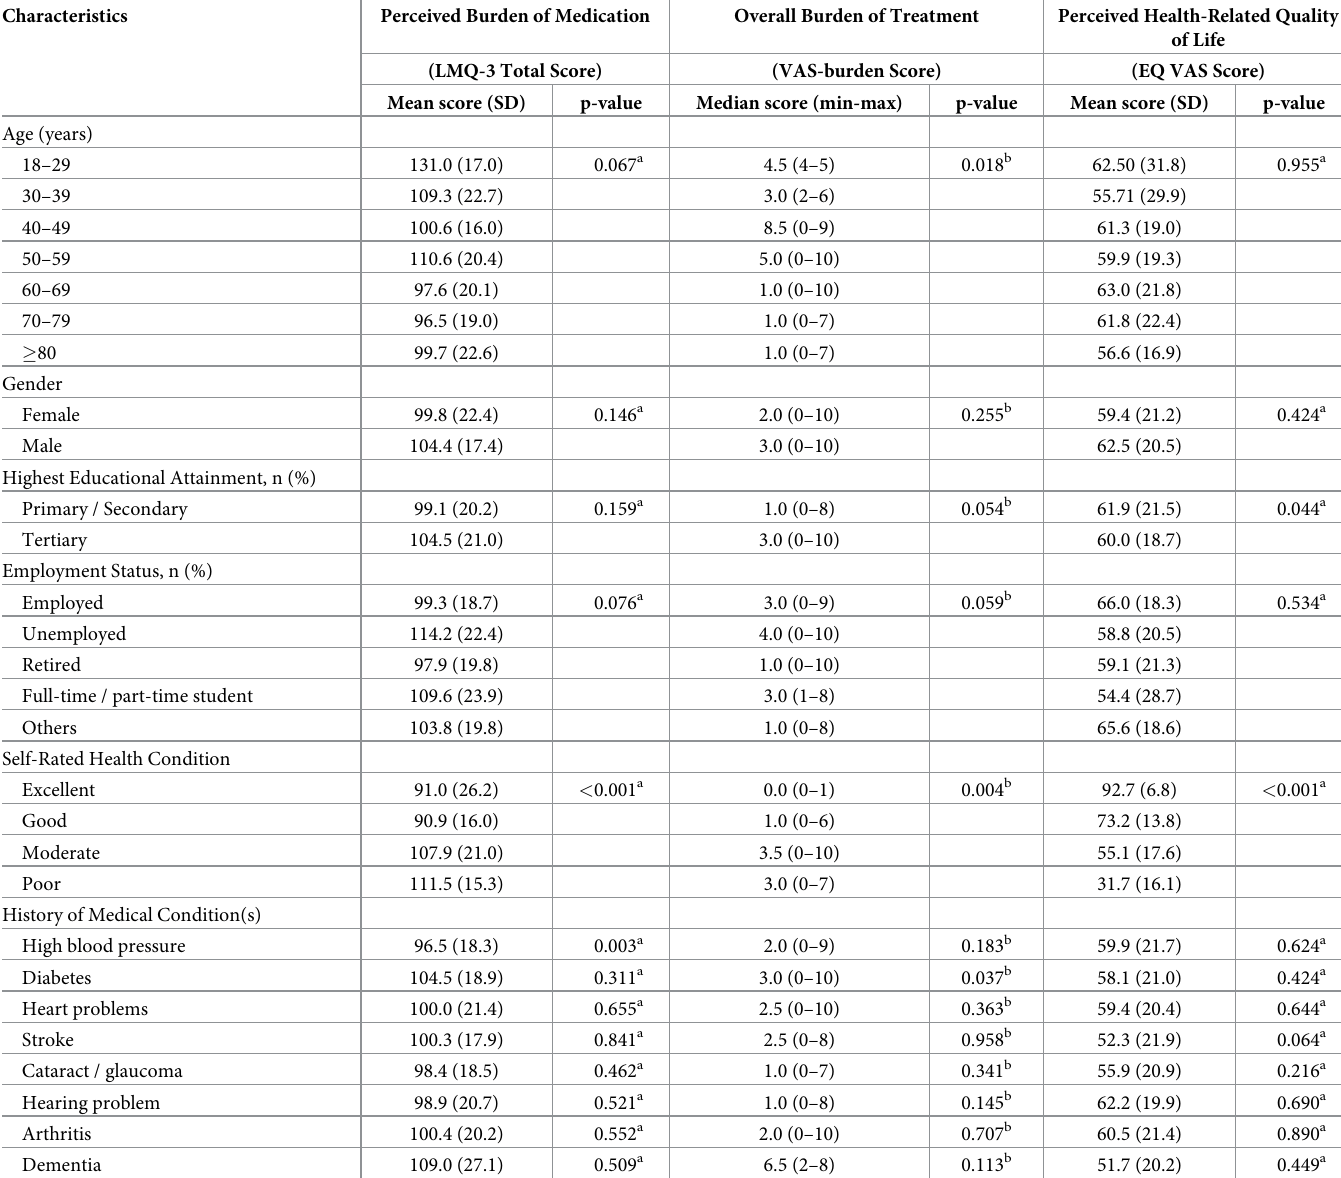
Table 2. Demographic and medicines used characteristics on LMQ-3 total score, VAS-burden score and EQ VAS score.